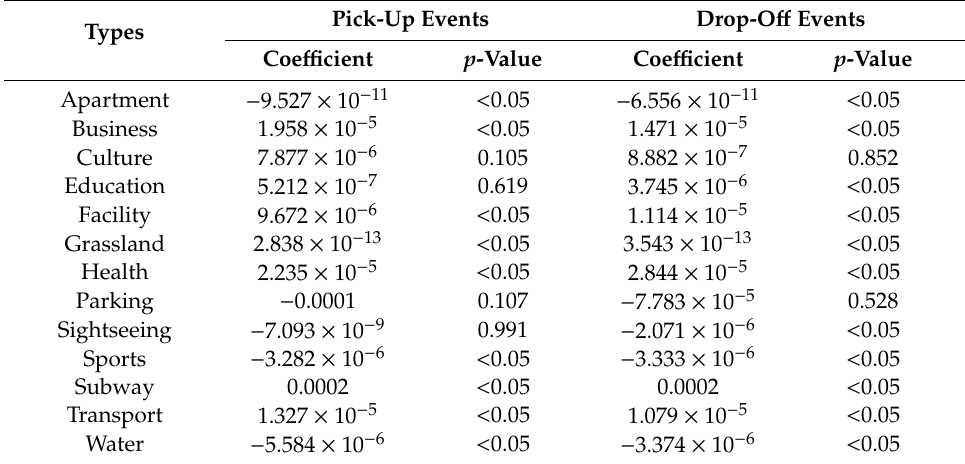
Table 5. Correlation results between ODs and land-use.